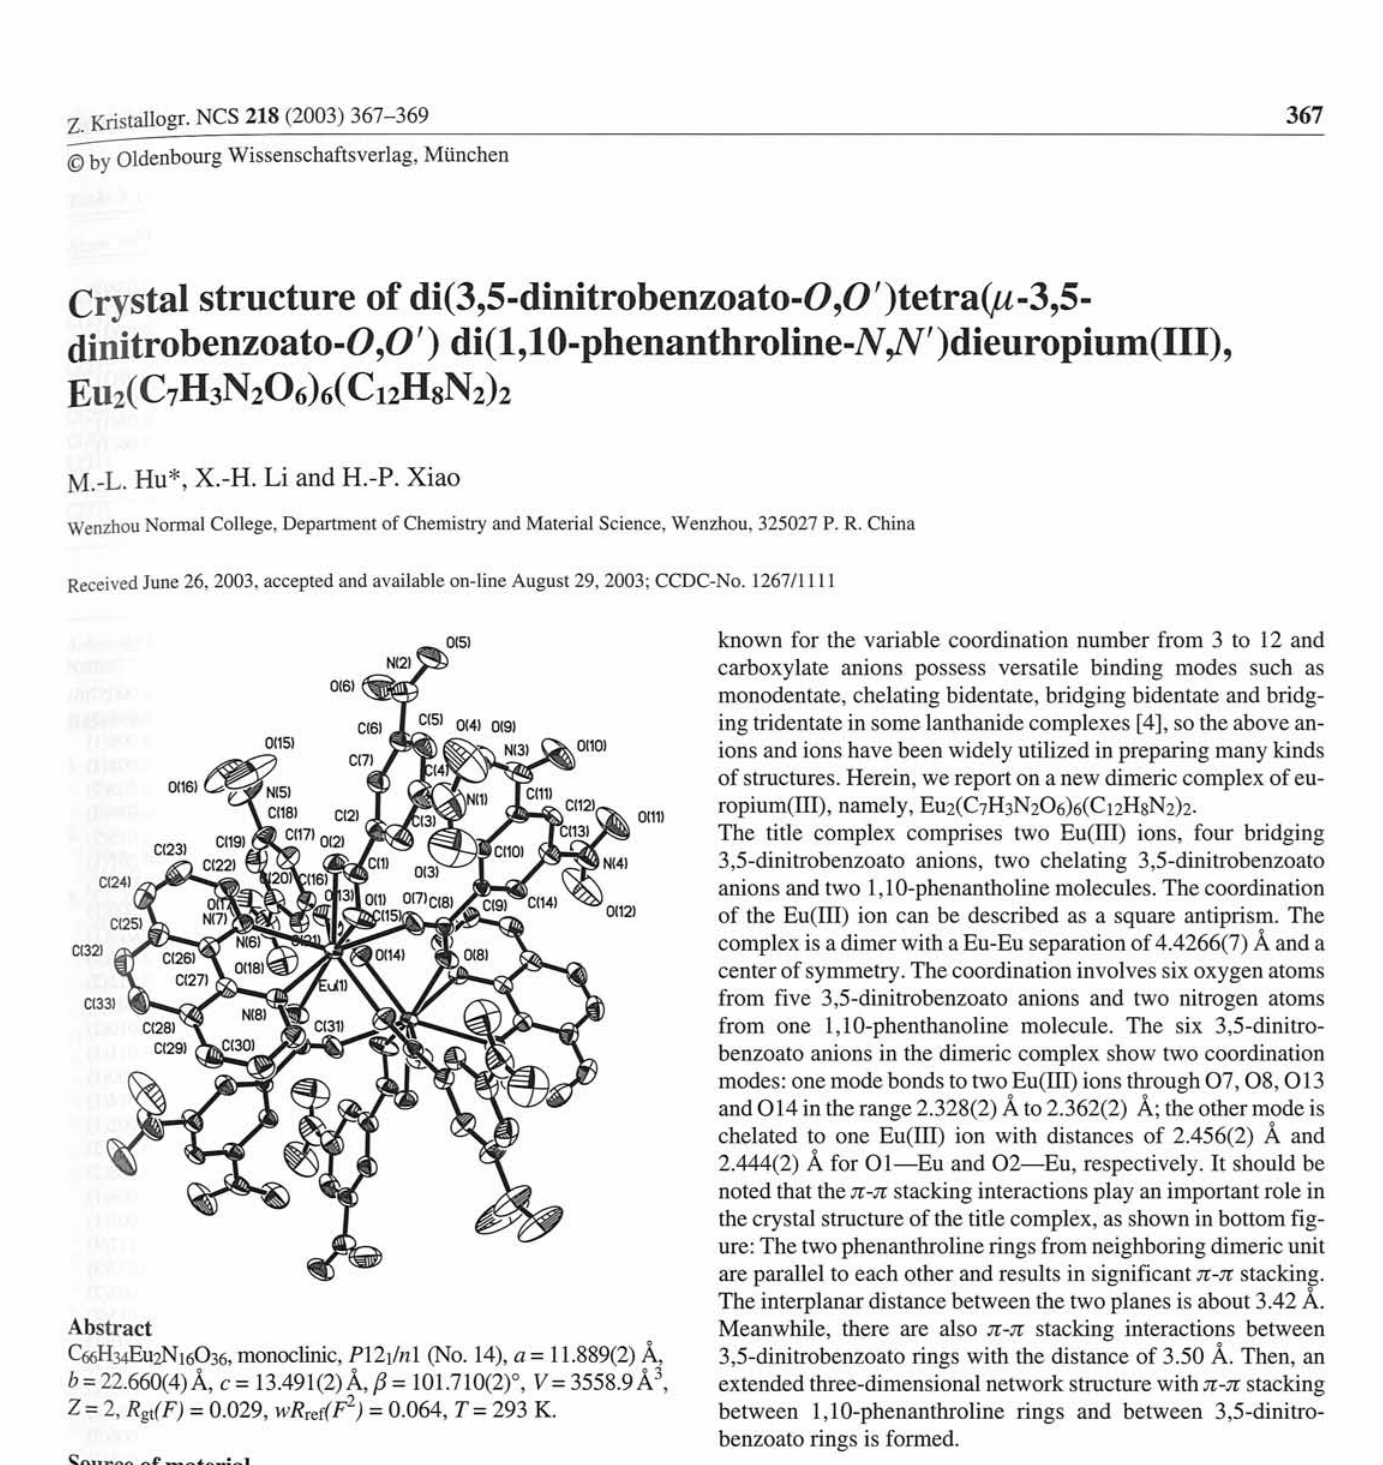
Table 1. Data collection and